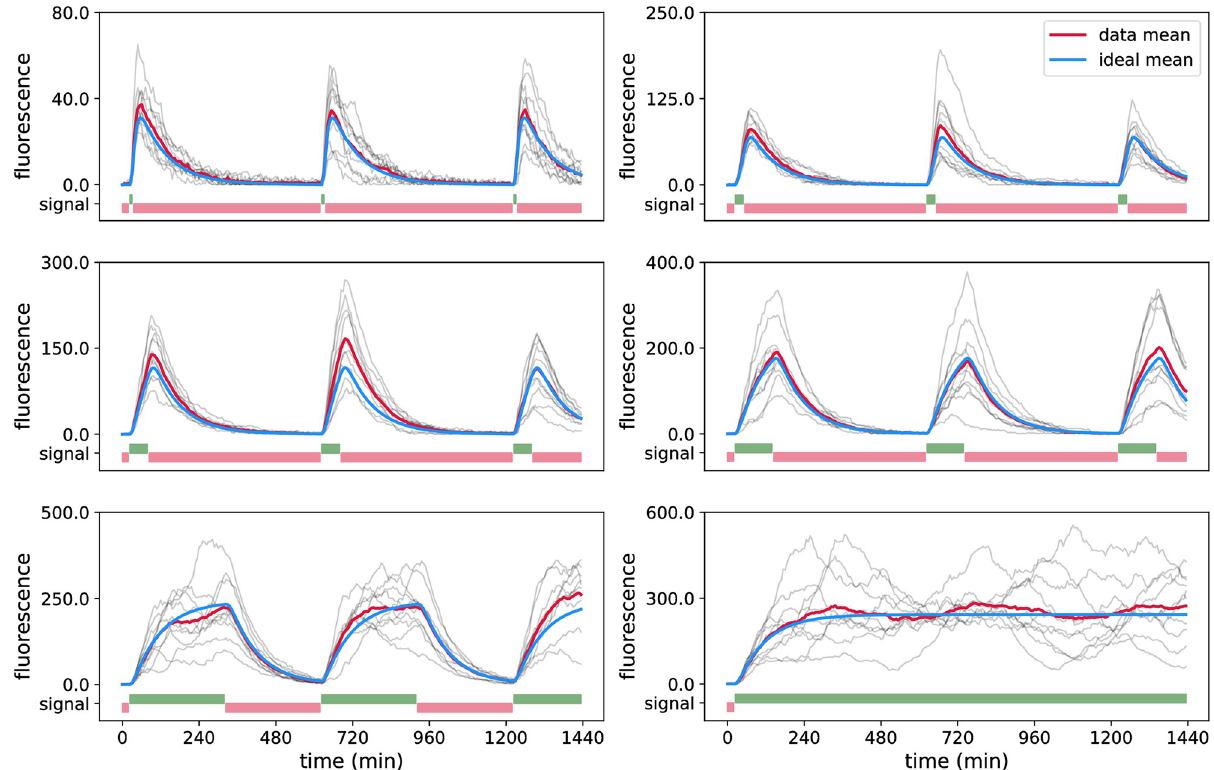
Fig 4. Simulated data for the CcaS/CcaR optogenetic system. One data set used for parameter inference for G0 is shown in the six panels. The different panels display cells exposed to different light inputs, u ( t ). The pulses of red and green light inputs are shown in red and green bars, respectively, at the bottom of each panel. Note that each light pattern starts with red light. Simulated data for 60 cells in total, 10 cells per panel, is shown in grey, the mean of the displayed cells in red, and the true mean (i.e. for infinitely many cells) is shown in blue. Parameter values are provided in Table A in S1 Text. Simulated data sets for other groups and different numbers of cells are shown in Figs A-C in S1